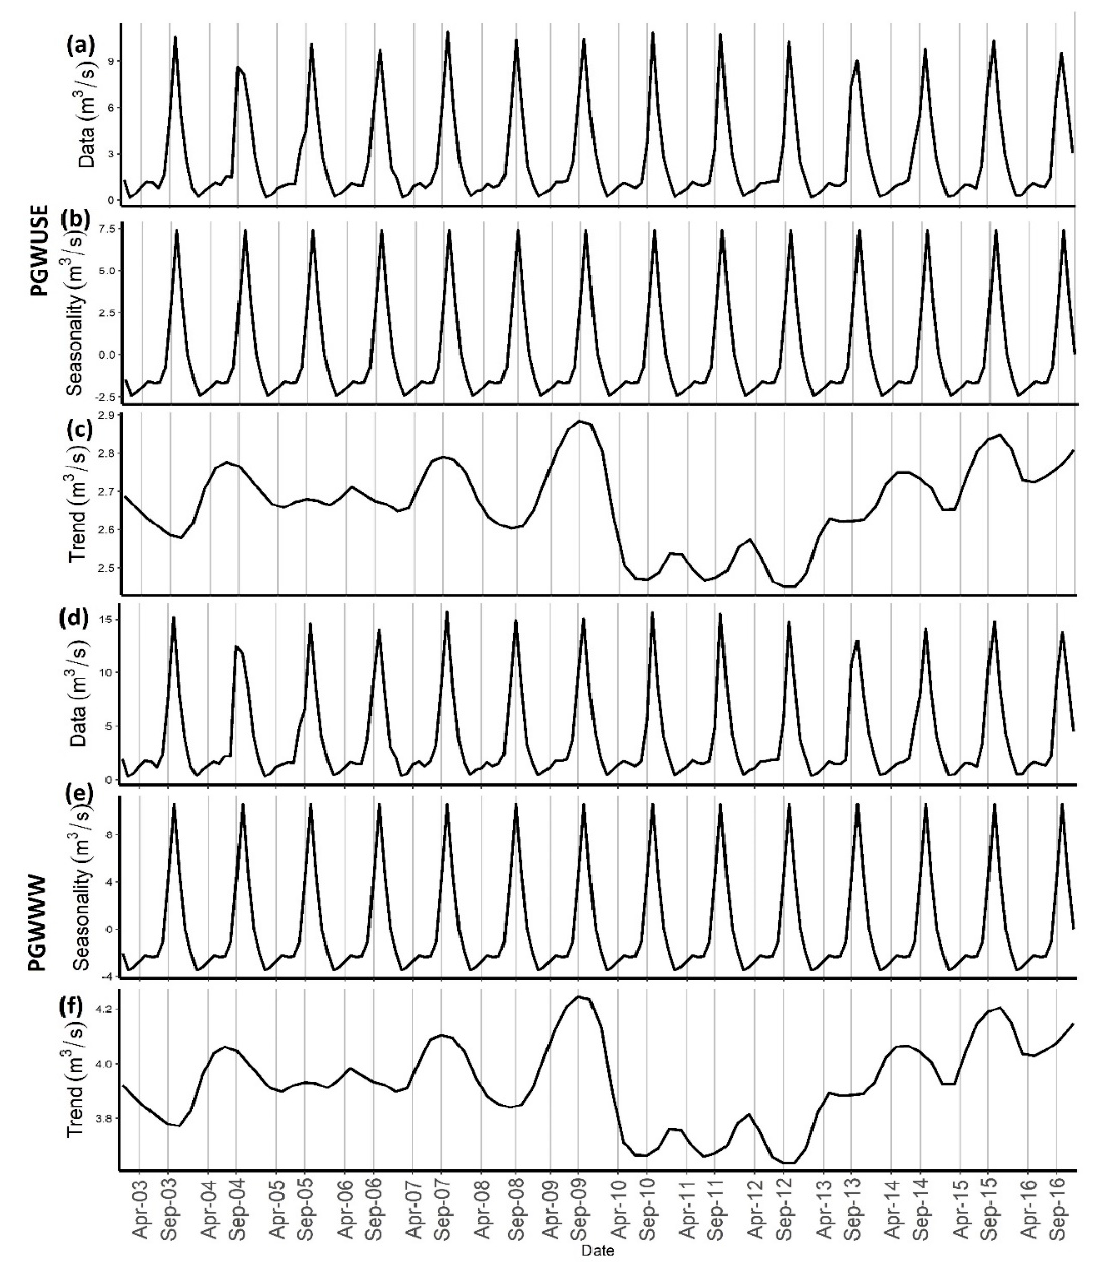
Figure 7. Time series: ( a ) data—PGWUSE; ( b ) seasonality—PGWUSE; ( c ) trend—PGWUSE; ( d ) data—PGWWW; ( e ) seasonality—PGWWW; and ( f ) trend—PGWWW over IRB during the 2003–2016